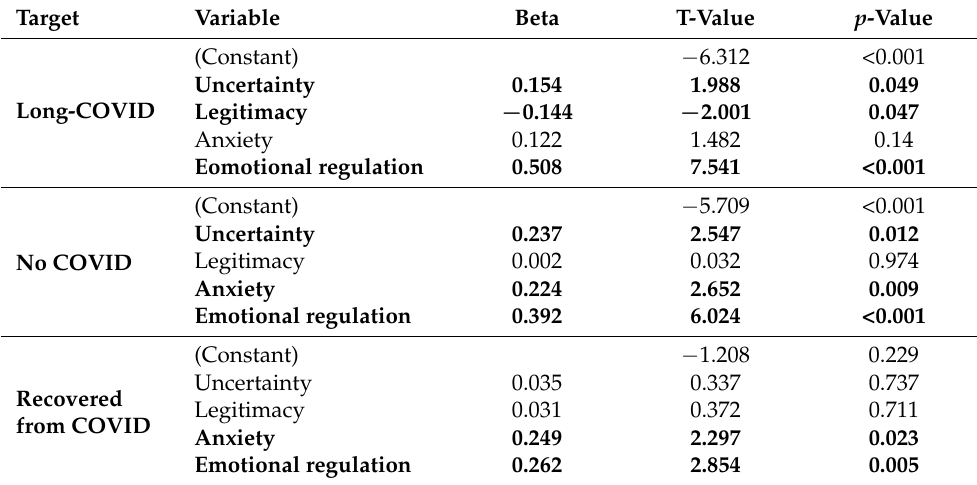
Table 4. Results of the regression analysis by